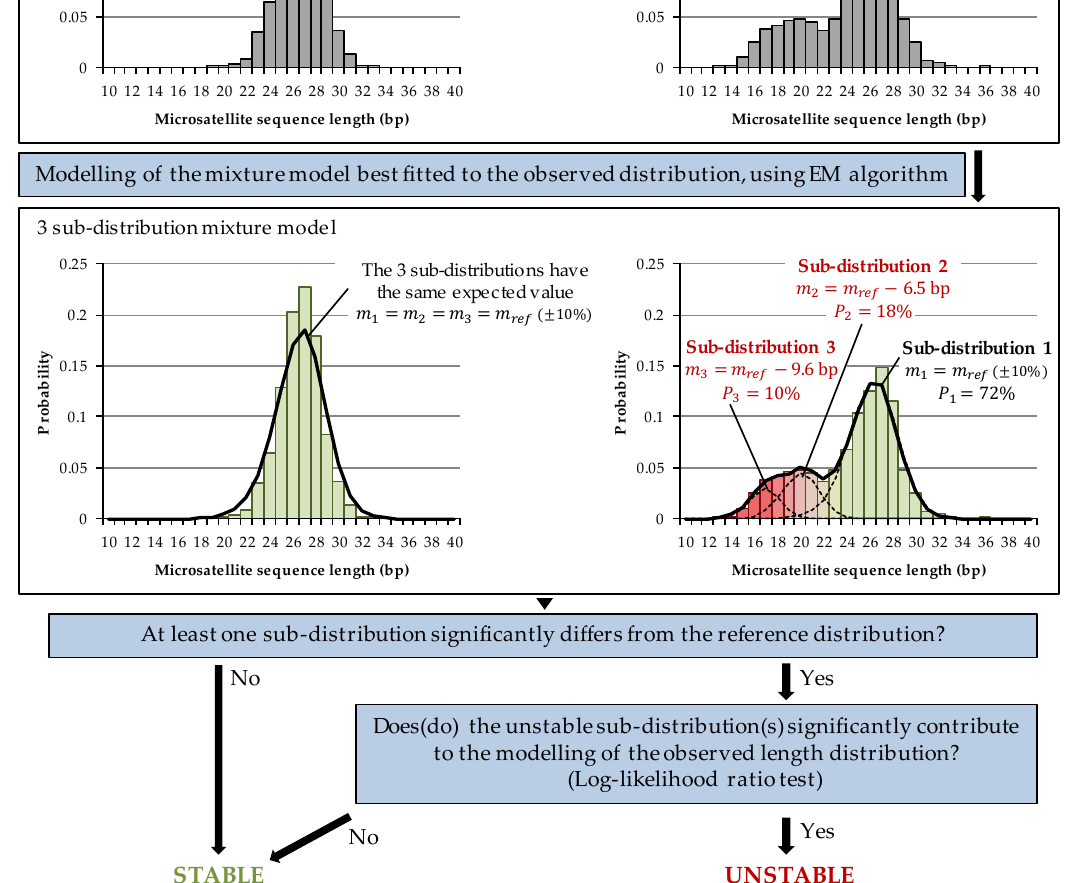
Figure 1. MEM workflow summary. Microsatellite sequences are obtained by trimming its 5 ′ and 3 ′ flanking sequences in unmapped reads when both are identified using Smith–Waterman alignment (see Supplementary Table S1 for parameters). The lengths of the microsatellite sequences are measured to determine their statistical distribution (left panel: example of a BAT-26 stable distribution; right panel: example of a BAT-26 unstable distribution). MEM uses the EM algorithm to build a three sub-distribution mixture model of the observed distribution. If at least one sub-distribution differs significantly from the reference distribution and contributes significantly to the modelling according to a log-likelihood ratio test, then the microsatellite is considered unstable; otherwise it is considered stable.